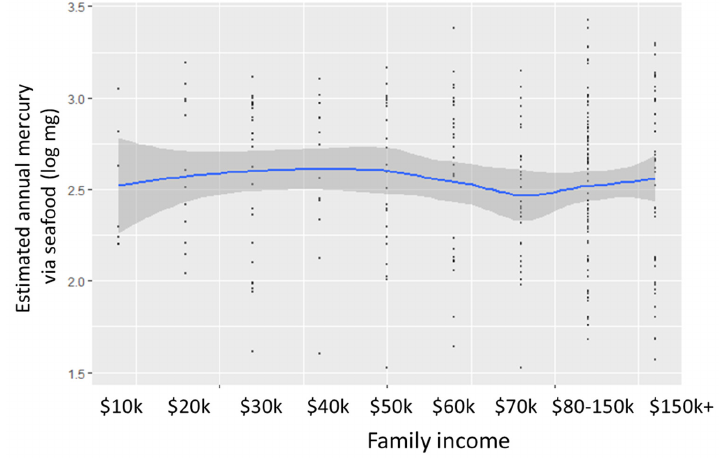
Figure 3. Annual mercury intake by family income.